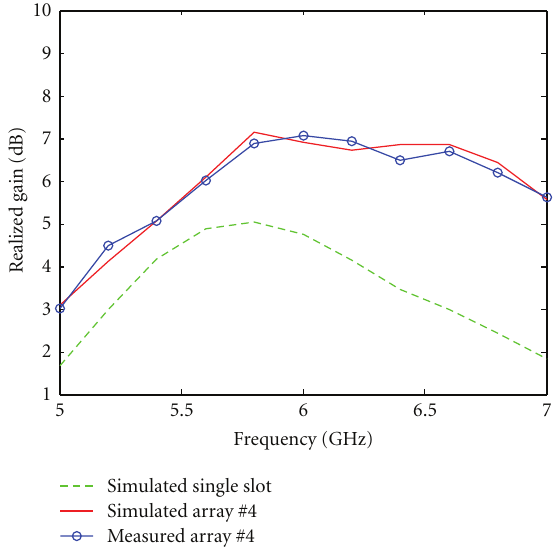
Figure 8: Simulated and measured gain results of single-slot and two-slot array no. 2 ( d = 14mm).